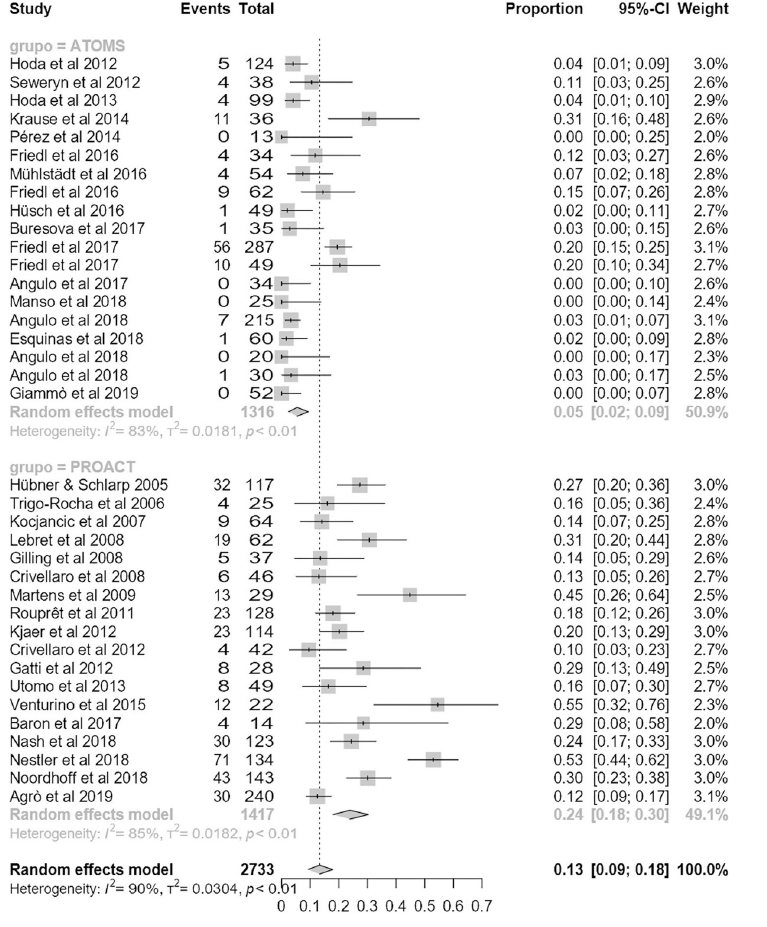
Fig 8. Forest plot of studies analyzed for explant